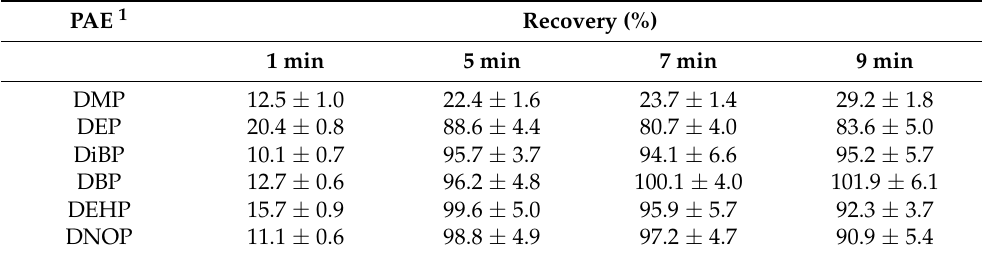
Table 3. Recovery (%) of each phthalate as the mechanical stirring times